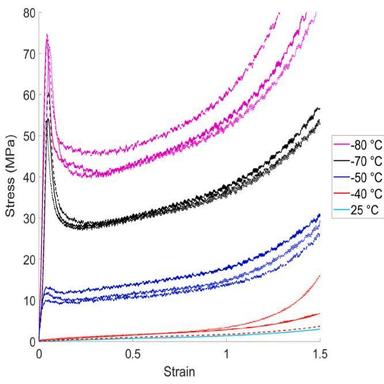
Low rate, varying temperature results for U-NR.